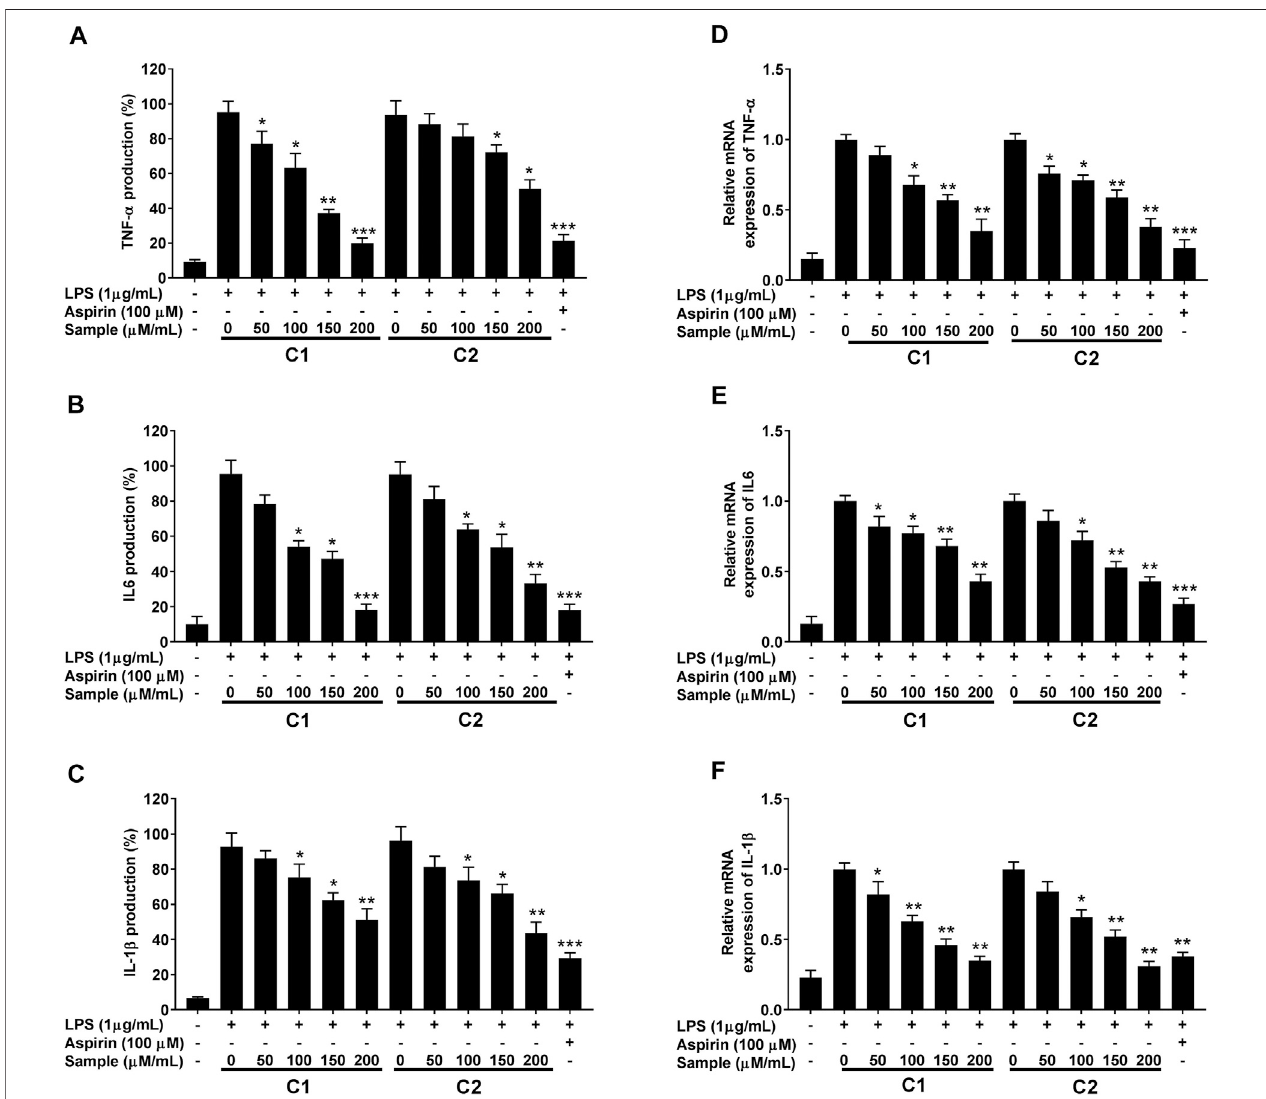
FIGURE9 | Inhibitory effect ofpuri fi ed compounds on pro-in fl ammatorycytokine production inRAW 264.7 cells. Cells (1.0 × 105 cells/ml) were stimulated by LPS (1 μ g/ml) for 24 h in the presence of compounds (2.5, 5, and 10 µ/ml). Supernatants were collected, the TNF- α , IL-6 and IL-1 β production in the supernatants was determinedbyELISA (A – C) .Geneexpressionwasanalyzed byquantitativeRT-PCRanalysisusinggenespeci fi cprimers (D – F ).Values arethemean ± standarderrorof triplicate experiments. Values are the mean ± standard error of triplicate experiments. * p < 0.05, ** p < 0.01 and *** p < 0.001 for the comparison with the LPS- stimulated